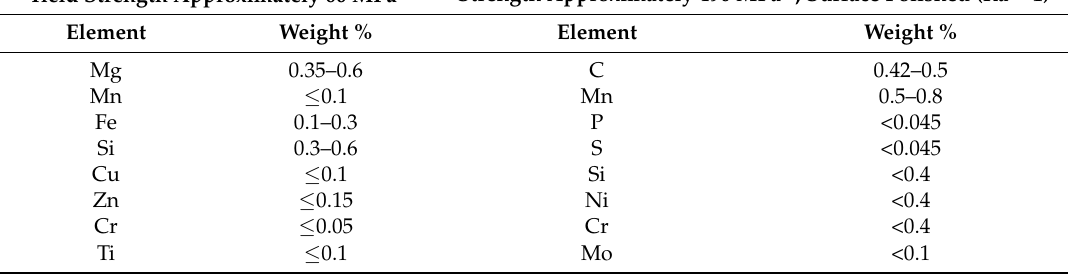
Table 2. Aluminum EN AW-6060 alloy composition adapted from [23] and steel C45 (1.0503) alloy composition adapted from [24].